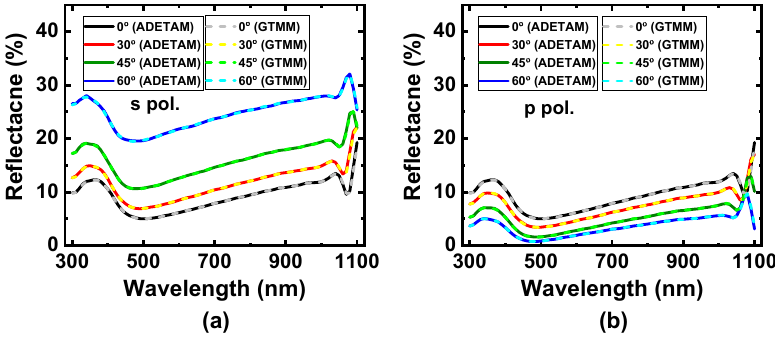
Figure 5. Comparison of the calculated reflectance spectra of the planar CIGS solar cell between the ADETAM and the GTMM at various incidence angles for ( a ) s- and ( b ) p-polarized light. The calculated reflectance spectra obtained by the ADETAM are well matched with the exact analytical results calculated by the GTMM.